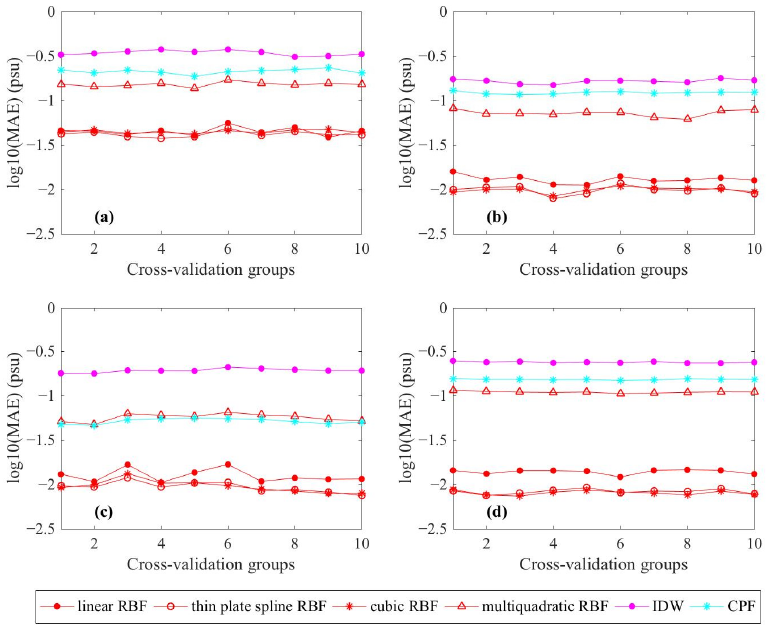
Figure 4. The log 10 (MAE) of each method in the 10-fold cross-validation experiments for salinity interpolation. ( a ) Summer 2010; ( b ) Summer 2011; ( c ) Autumn 2010; and ( d ) Autumn 2011. Table 3. The average MREs of different interpolation methods with in situ temperature. 3D Interpolation